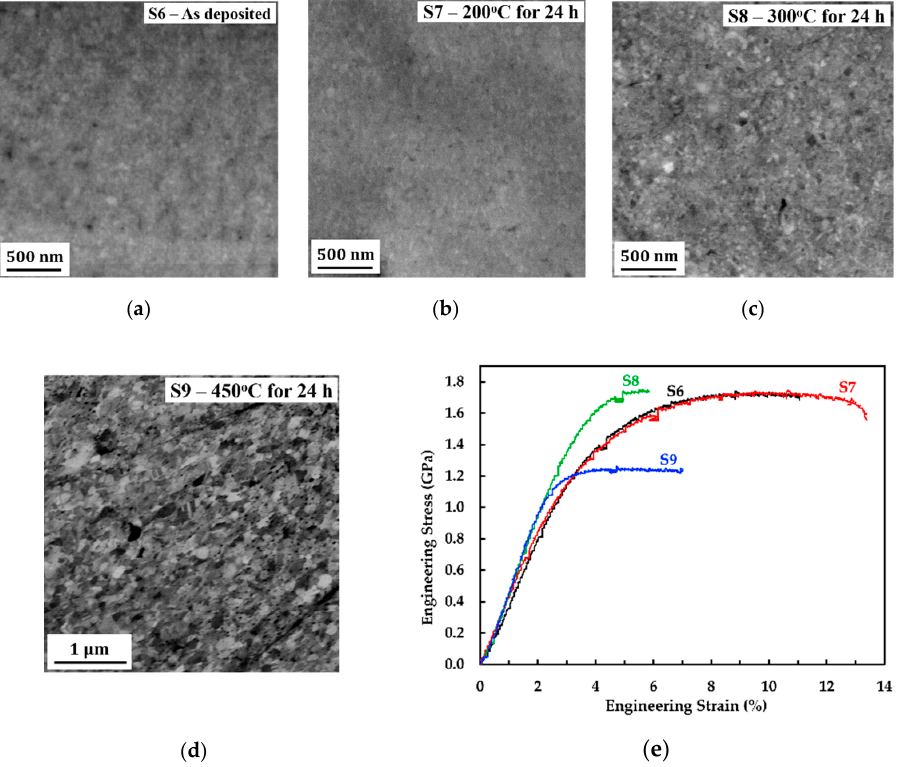
Figure 7. ( a – d ) BSE images of initial microstructure of ( a ) sample 6 (S6), ( b ) sample 7 (S7), ( c ) sample 8 (S8), and ( d ) sample 9 (S9) in planar mode; ( e ) engineering stress vs. strain curves of static tensile test at a strain rate of 1.0 × 10 − 3 s − 1 of sample 6 (S6)–sample 9 (S9). The description for each sample is shown in the Table 3. Table 3. Description of tensile specimens S6–S9 with the Identical thickness (D) and chemical composition which were deposited for 72 h at pulse current density (i p ), duty cycle (DC), and pulse-on time (t p ) of 900 A/m 2 , 10%, and 0.3 ms, respectively. Samples S7–S9 were annealed at different temperatures for 24 h. The yield strength ( σ y ), ultimate tensile strength ( σ u ), and total elongation at fracture ( ε f ) are measured from the engineering stress–strain curves in Figure 7e. Two tensile specimens were mechanically tested for S6 and S9. Annealing Composition Mechanical